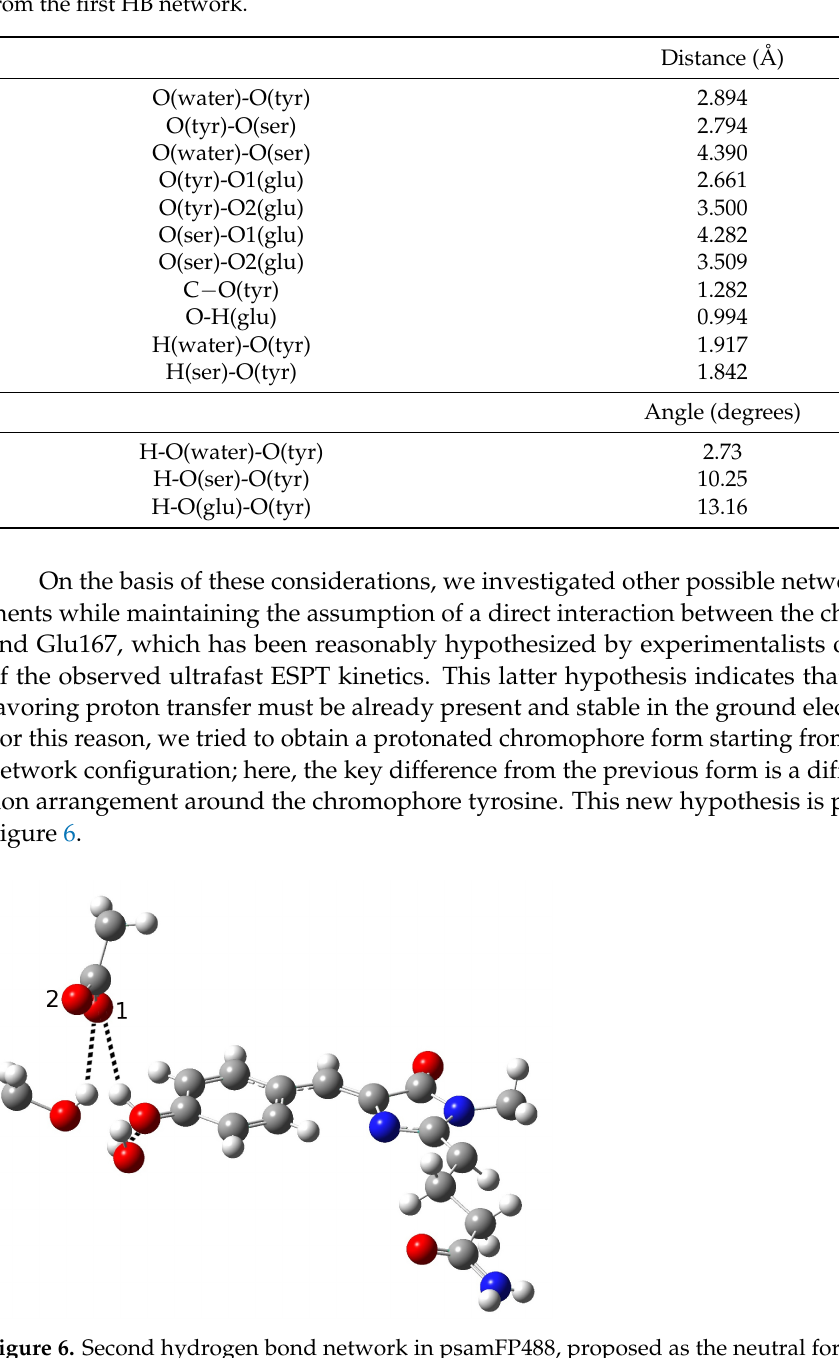
Table 1. Structural parameters (distances (Å) and angles (degrees)) of psamFP488 optimized starting from the first HB network.